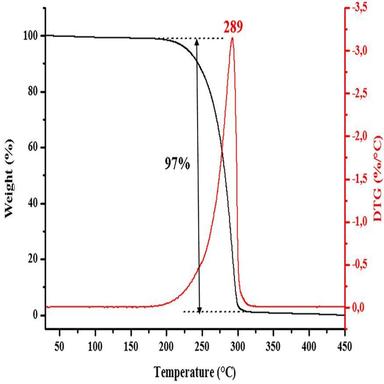
TGA/DTG curve of (C8H12N)42 compound.